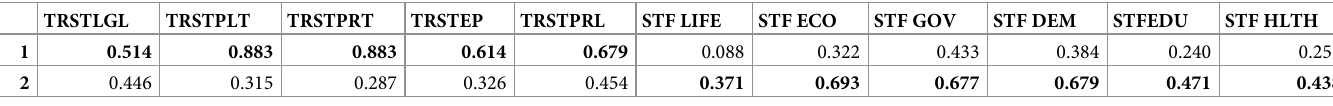
Table 4. Factor loadings for